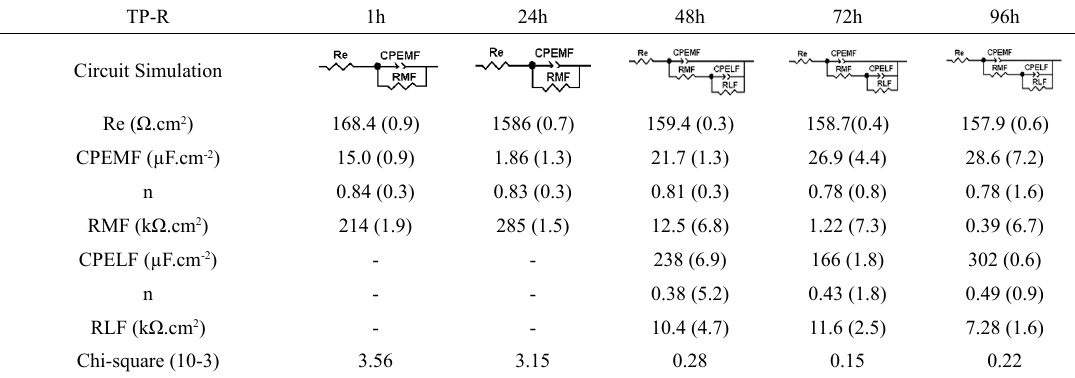
Table 5. Equivalent circuits for the TP-R sample. The error percentage is in parentheses. TP-R 1h 24h Circuit Simulation Re (Ω.cm 2